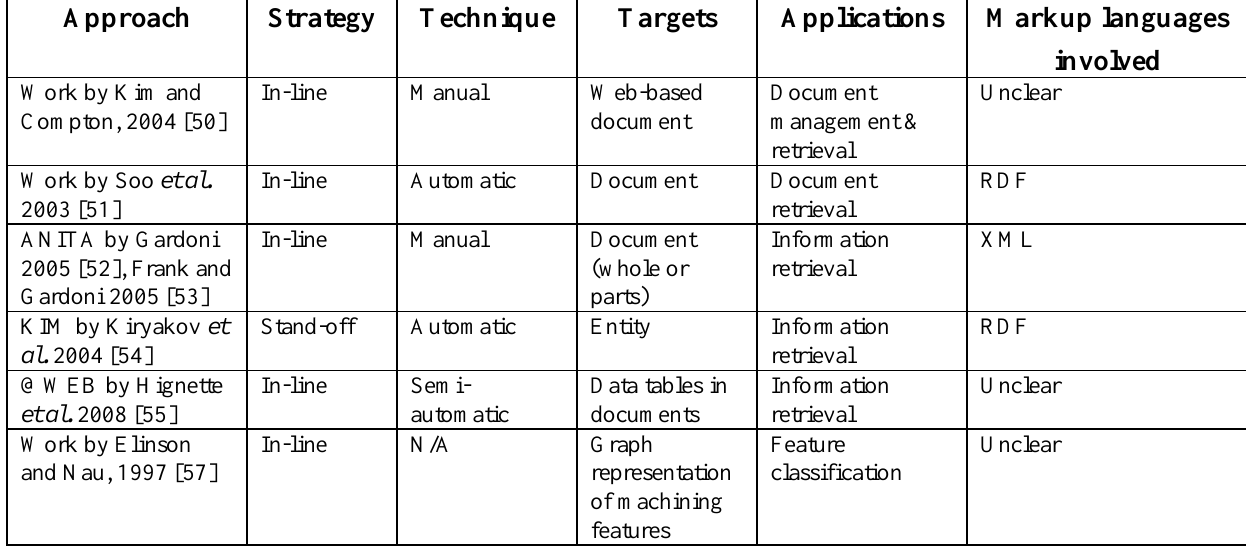
Table 3. Work on applications in